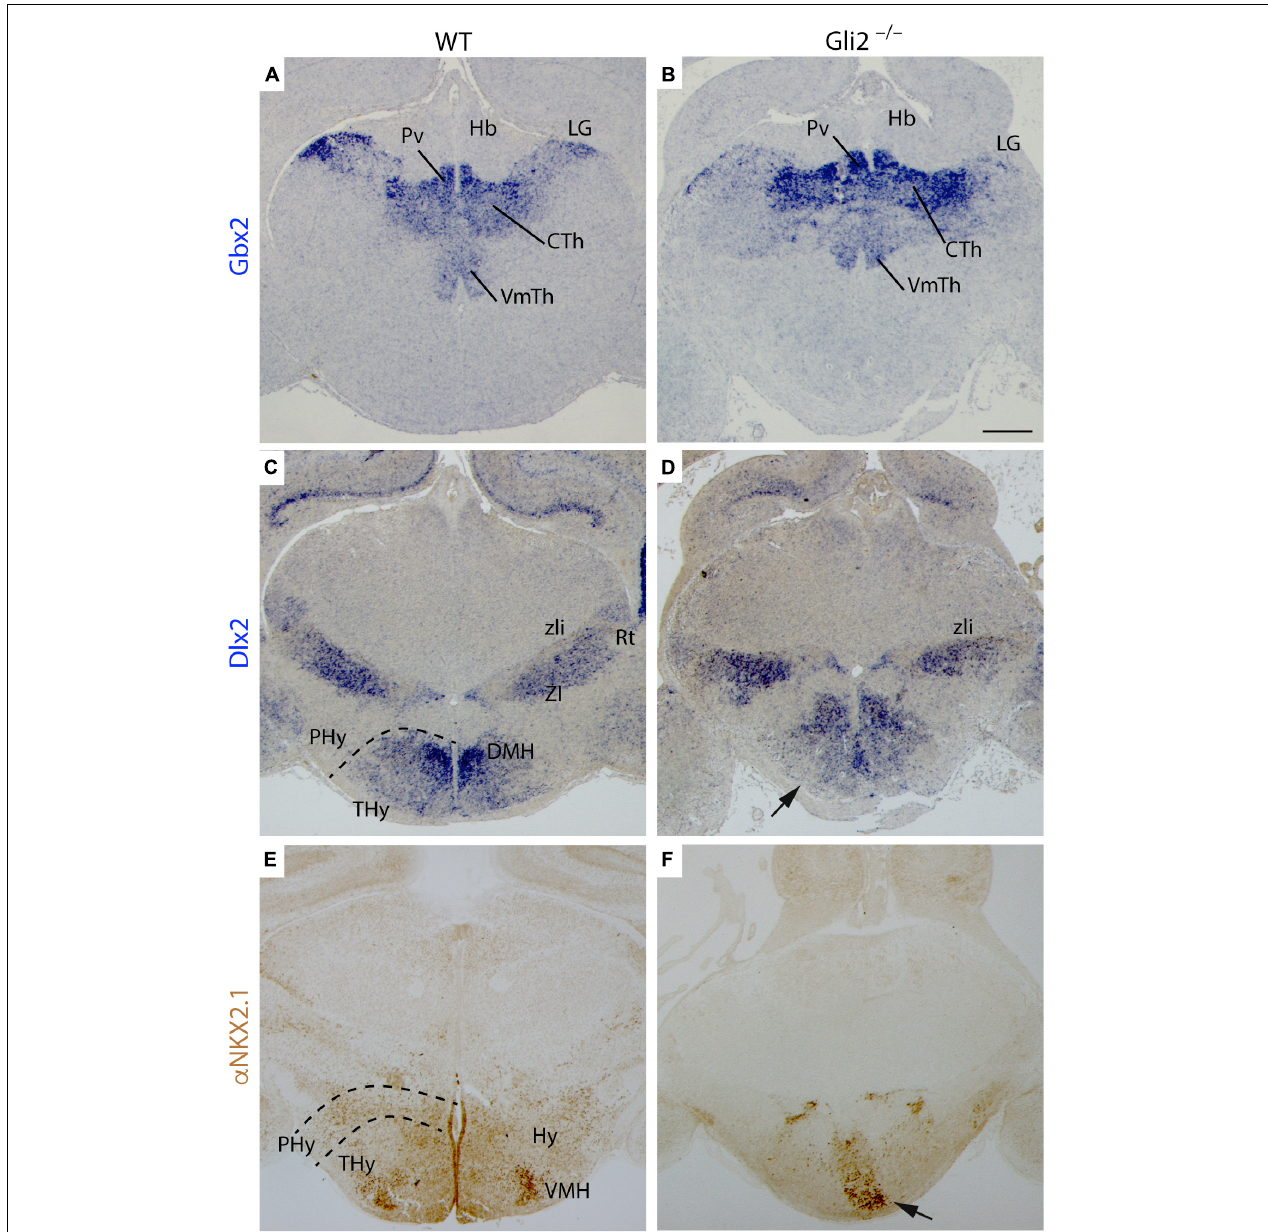
FIGURE 4 | Specification of diencephalon and secondary prosencephalon territories in Gli2 mutant mice. Frontal sections through wild-type and E18.5 Gli2 − / − embryos. (A,B) Gbx2 in situ hybridization. (C,D) Dlx2 in situ hybridization. (E,F) α -NKX2.1 immunohistochemistry in brown. The dotted lines indicate the alar-basal boundary. The Gbx2 expression in the LG, CTH, and PvTh nucleus of Gli2 − / − thalamus is similar to the one observed in the control (A,B) . Dlx2 labels the prethalamic ZI and Rt with a similar pattern than in the control (C,D) . Dlx2 is also expressed in DMH in the basal THy of wild type although in Gli2 − / − , this expression was not detected [arrow in (D) ]. α -NKX2.1 had a scattered distribution in the basal THy, but presented a dense labeling of a VMH subnuclei. This distribution was strongly affected in the mutant [arrow in (F) ]. CTh, Central thalamus nucleus; DMH, Dorsal medial hypothalamus nucleus; LG, Lateral geniculate nucleus;